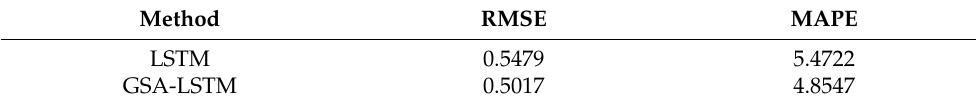
Table 4. Prediction results of the LSTM and GSA-LSTM method for the NG pipeline